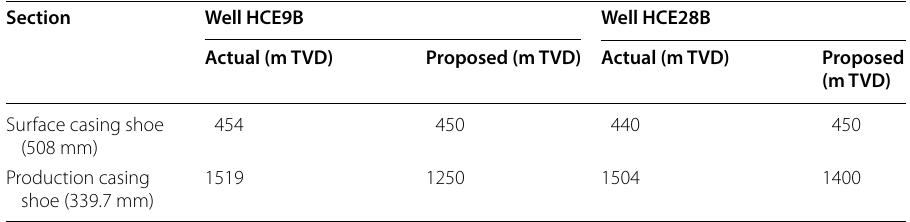
Table 3 Actual vs proposed casing setting depth Section